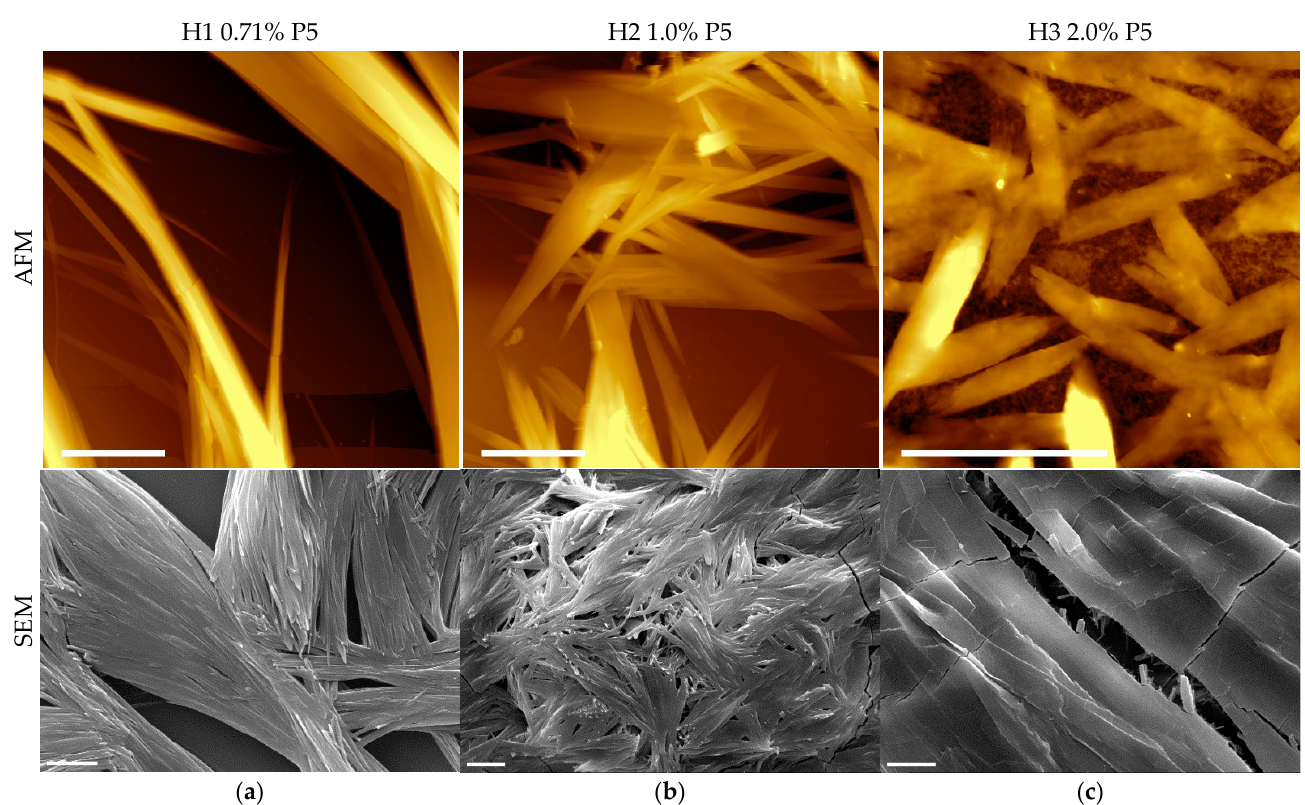
Figure 3. Representative AFM (top) and SEM (bottom) images of hydrogel H1 ( a ), H2 ( b ), H3 ( c ) (scale bar represents 5 μ m in AFM images and 10 μ m in SEM images).